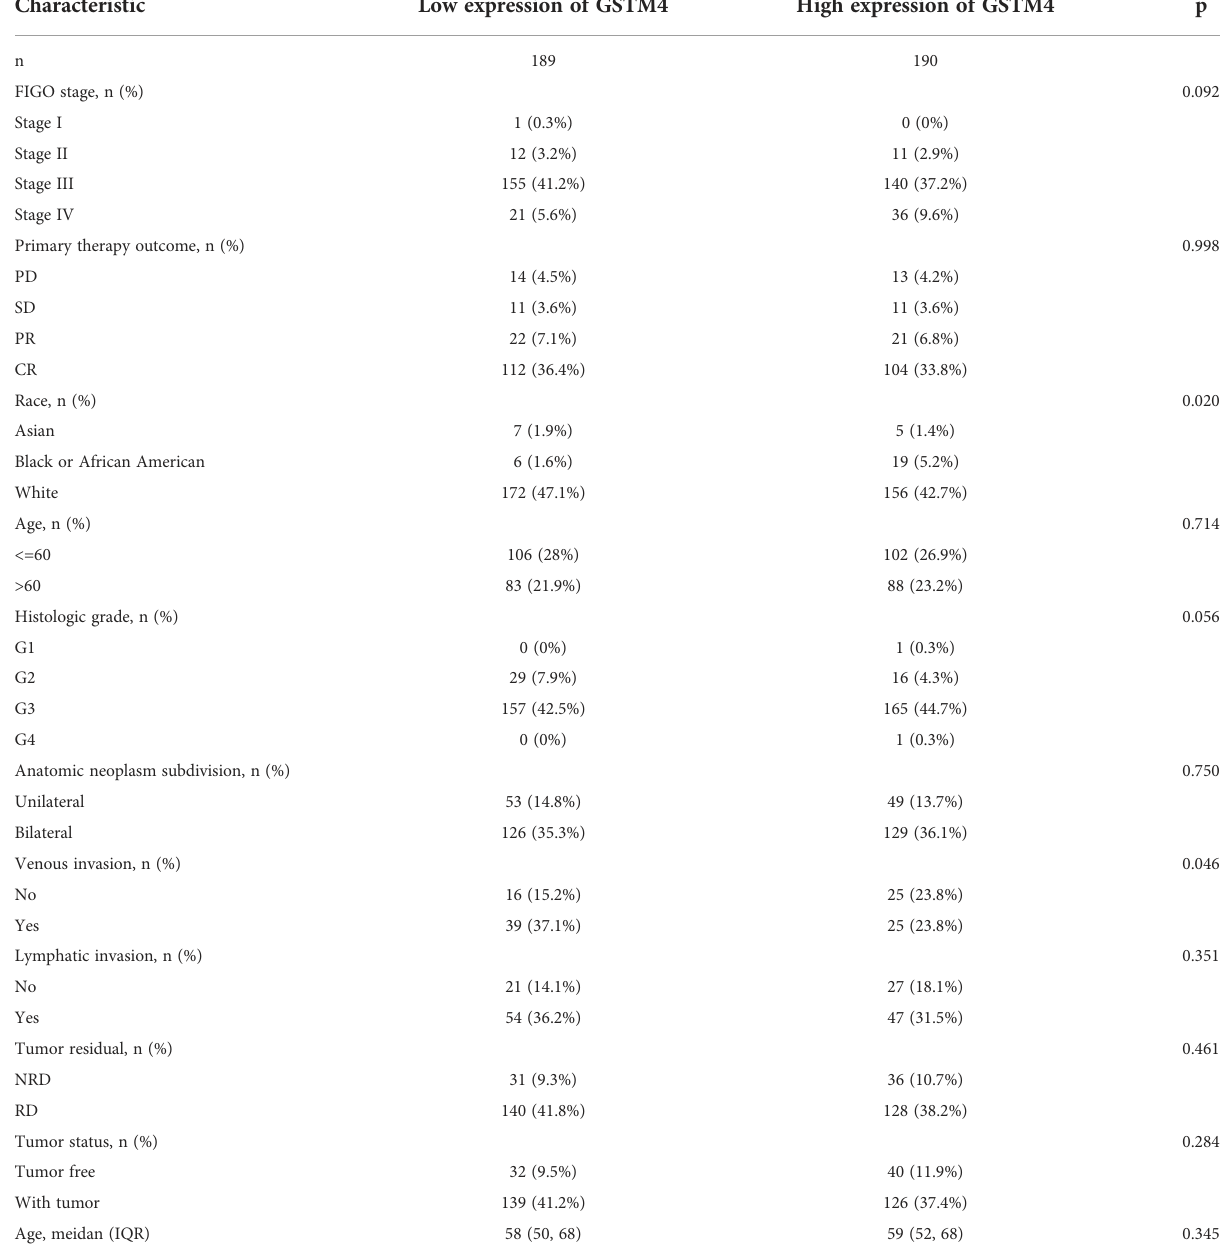
TABLE 4 The correlation between pathological parameters and GSTM4